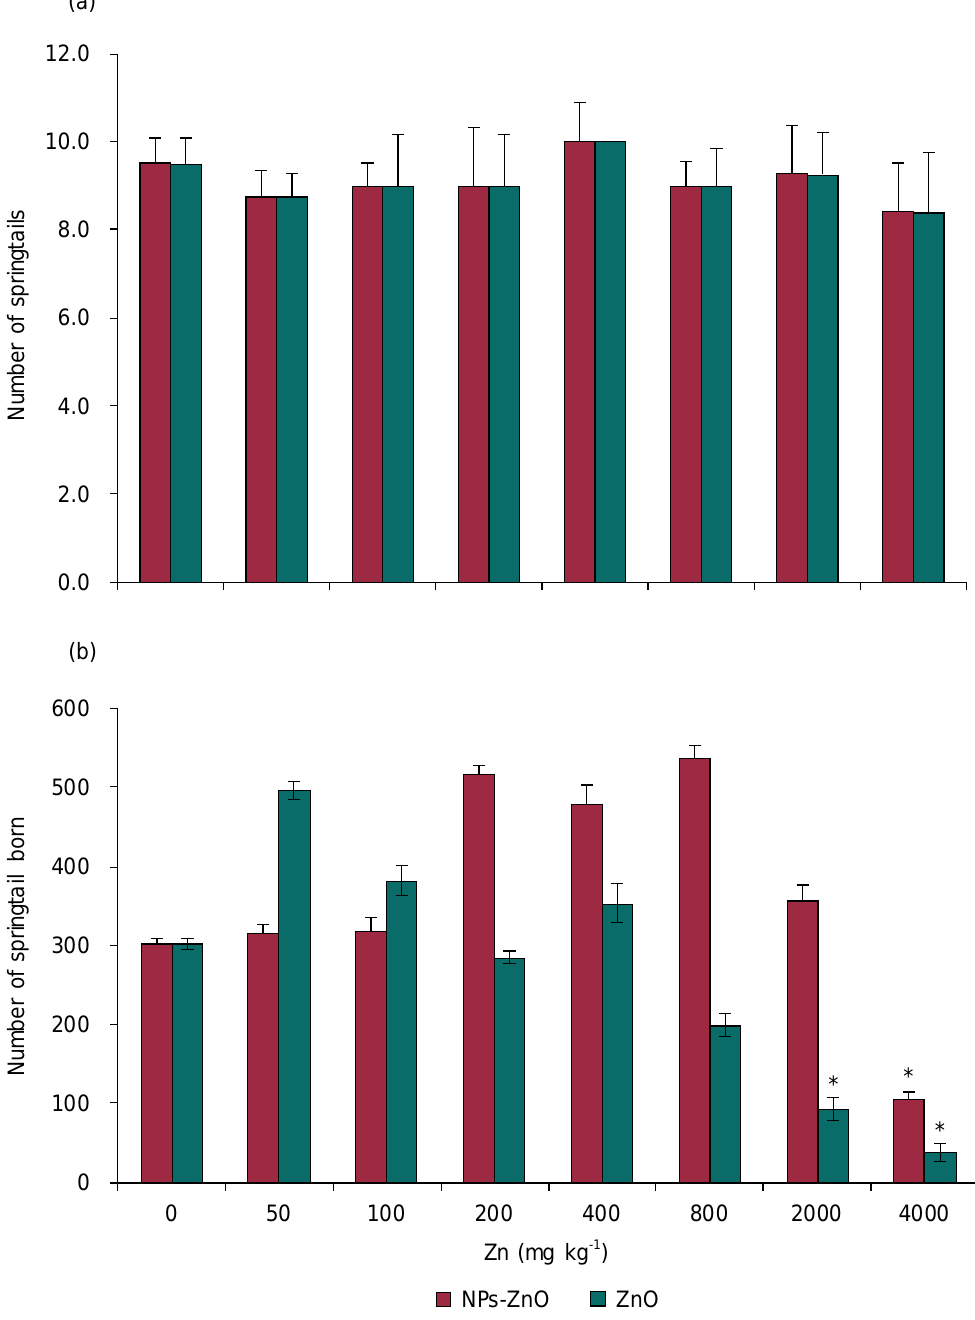
Figure 3. Mean number and standard deviation of mean live adults (a) and juveniles per treatment (b) F. candida , in an Entisol Typic Quartzipsamments contaminated with zinc oxide nanoparticles (NPs-ZnO) and non-nano zinc oxide (ZnO). * Significant reduction (p<0.05) for treatment (50, 100, 200, 400, 800, 2,000, and 4,000 mg kg -1 , dose-dependent effect) compared to the control (0 mg kg -1